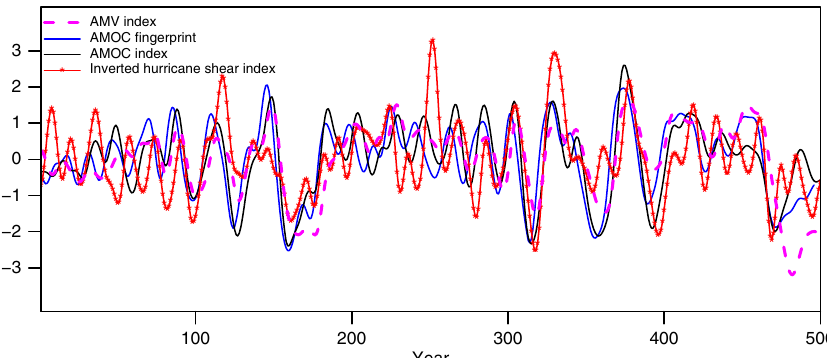
Fig. 4 Modeled low frequency anomalies from the GFDL-ESM2G control simulation. Coherent variations are shown for the Atlantic Multidecadal Variability (AMV) Index (dashed magenta), the Atlantic Meridional Overturning Circulation (AMOC) Fingerprint (solid blue), the AMOC Index at 26°N (solid black) and the Inverted Hurricane Shear Index during the Atlantic hurricane season (JJASON) (solid red with stars). The AMOC Fingerprint is shifted backward by 4 years to represent AMOC anomalies at mid-high latitudes. All time series are 10-year low-pass fi ltered and normalized by their own standard deviation over the entire